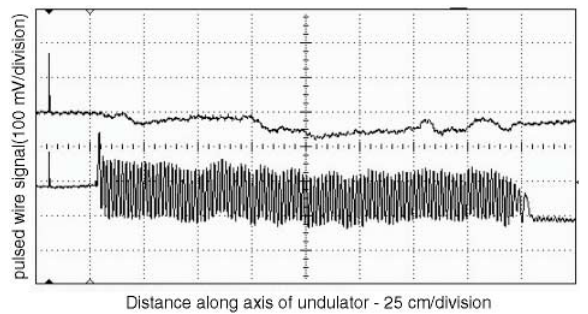
FIG. 8. The horizontal (lower curve) and vertical (upper curve) trajectories, as measured by the stretched wire apparatus. The graph shows data for two undulator sections butted together, after shimming has been done to compensate for errors at the joint between them. The overall error is well within 10% of the wiggle amplitude per gain